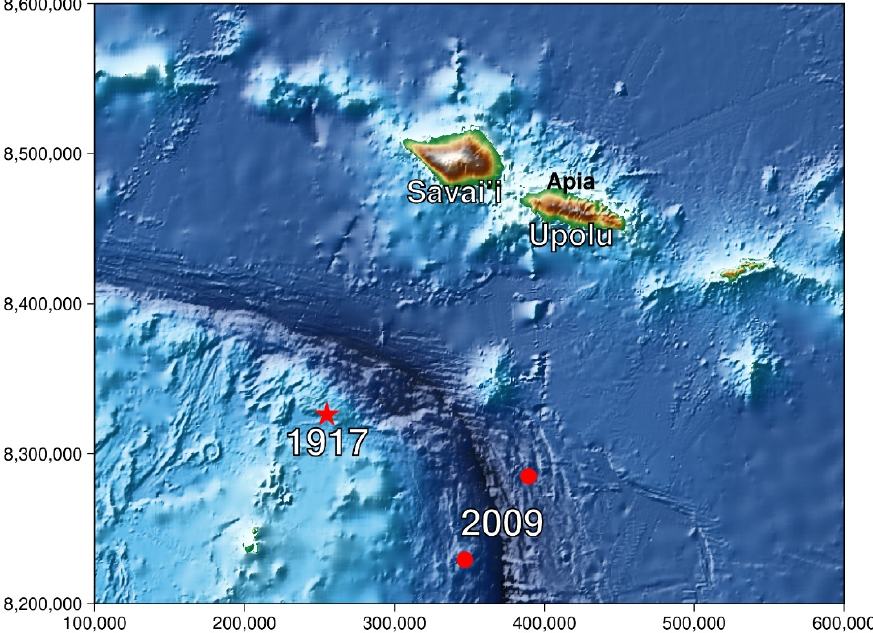
Figure 1. Location of the 1917 earthquake epicentre (star) and 2009 earthquakes (circles) relative to Samoa.